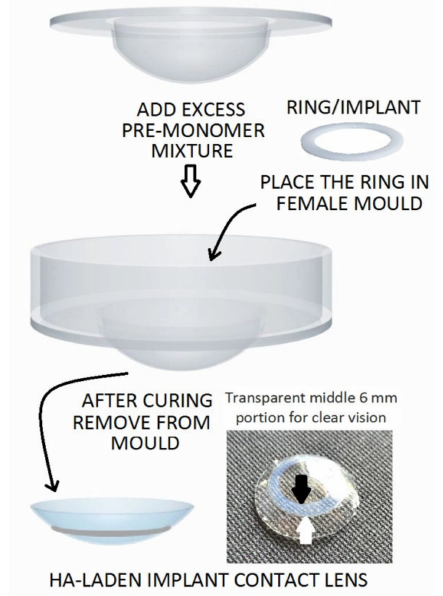
Figure 3. Proposed HA-laden embedded contact lens with a modified cast-molding method (the white arrow indicates the outer margin and the black arrow indicates the inner margin of the ring